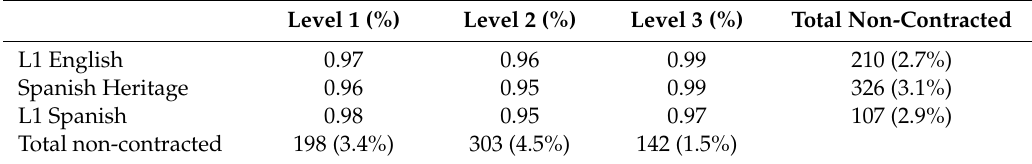
Table 7. Distribution of percentage of contractions across L1 group and L3 Portuguese level 3